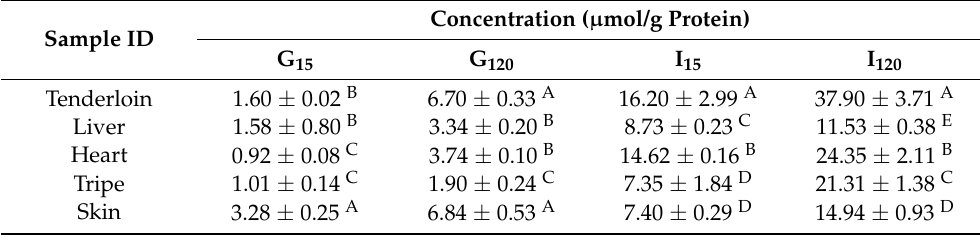
Table 1. Liberation of primary amino group after the in vitro gastric (G 15 and G 120 ) and gastrointesti- nal (I 15 and I 120 ) digestion of tenderloin and edible pork by-product. Sample